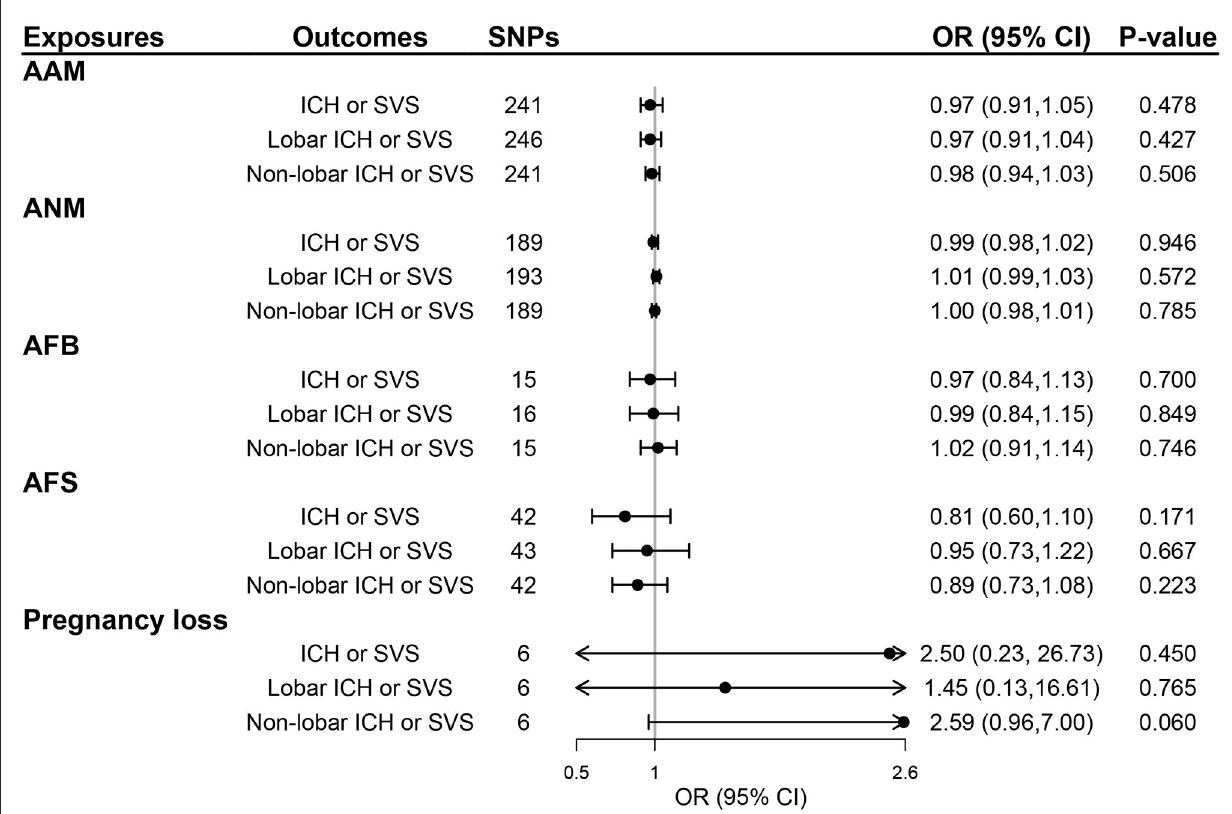
FIGURE2 The effect of genetically determined women’s reproductive traits on CSVD clinical outcomes using UVMR. AAM, age at menarche; AFB, age at first birth; AFS, age at first sexual intercourse; ANM, age at natural menopause; ICH, intracerebral hemorrhage; SVS, small-vessel ischemic stroke.